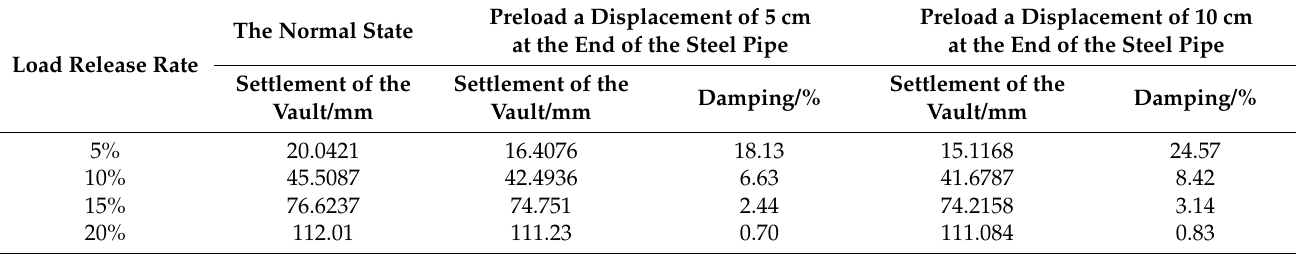
Table 3. The influence of four active bearing FSPs of 50 × 5 mm on settlement of the arch vault.